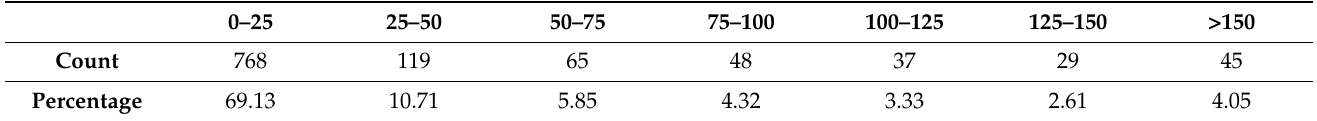
Table 12. Distance error ( ε ) distribution of the final model (in